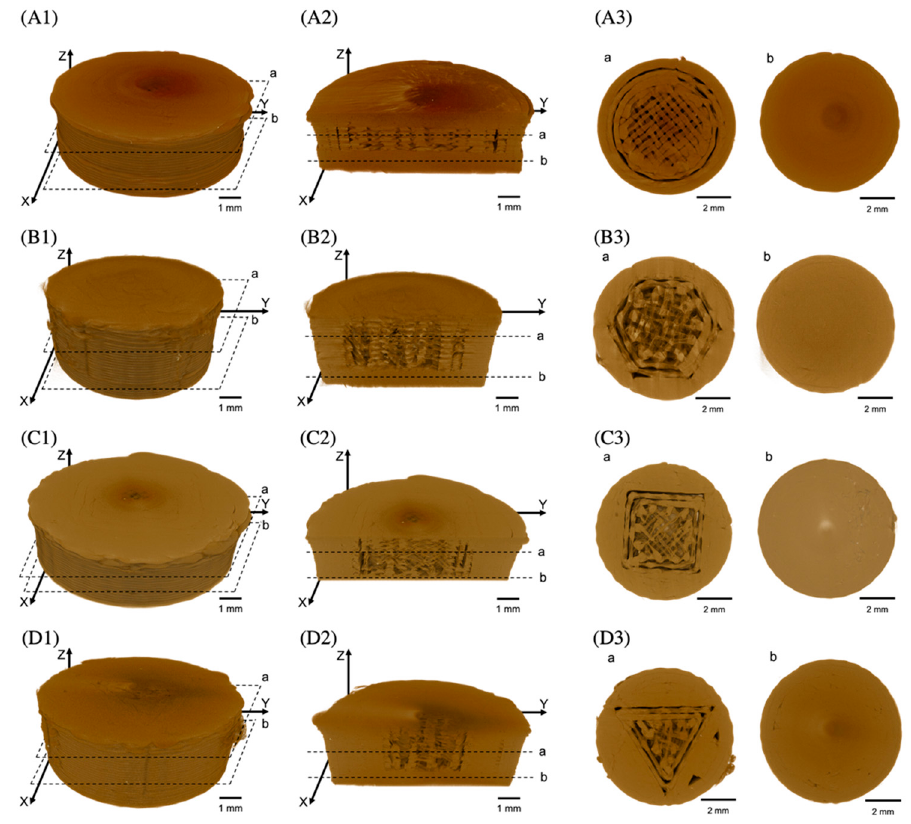
Figure 6. SRXTM images of FDP ‐ loaded 3D ‐ printed tablets with different inner surface geometries, showing ( A1 , B1 , C1 , D1 ) the entire tablet, ( A2 , B2 , C2 , D2 ) a vertical cross ‐ section of the tablet, and ( A3 , B3 , C3 , D3 ) a horizontal cross ‐ section of the tablet. The horizontal cross ‐ section view images were created using the indicated positions (a and b).